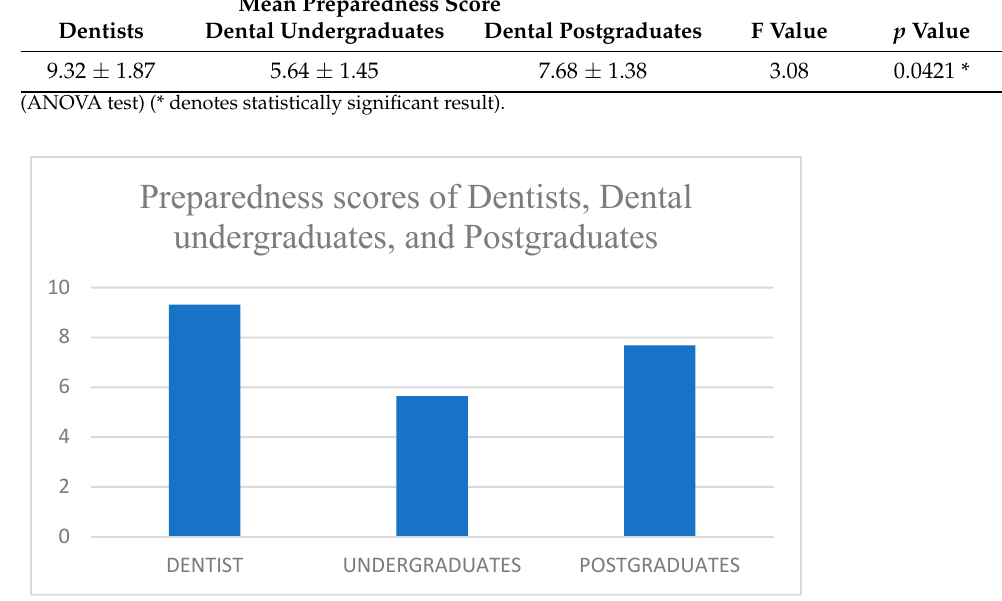
Table 5. Intergroup comparison of preparedness score between dentists, dental undergraduates, and postgraduates.